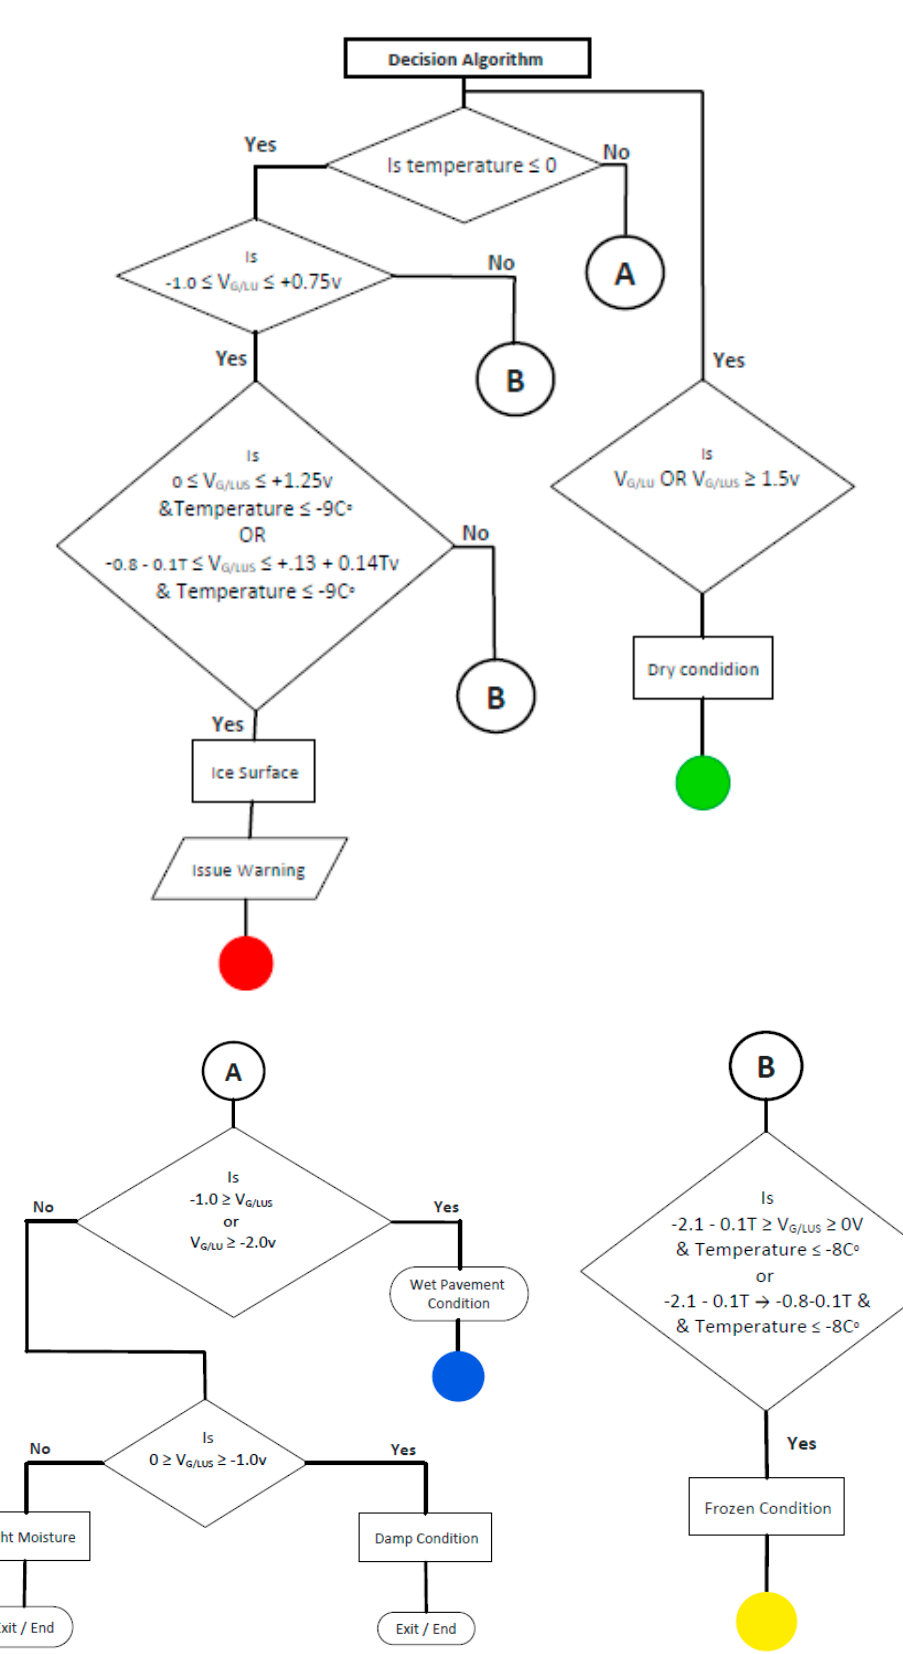
Figure 19. Preliminary decision algorithm for the concrete sensor.